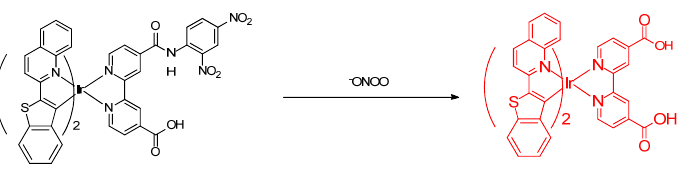
Figure 74. Cleavage by peroxynitrite by Fan, Wong, Wu et al. Kim et al. reported a 7–diethylamino–3–formylcoumarin system (Figure 75). There